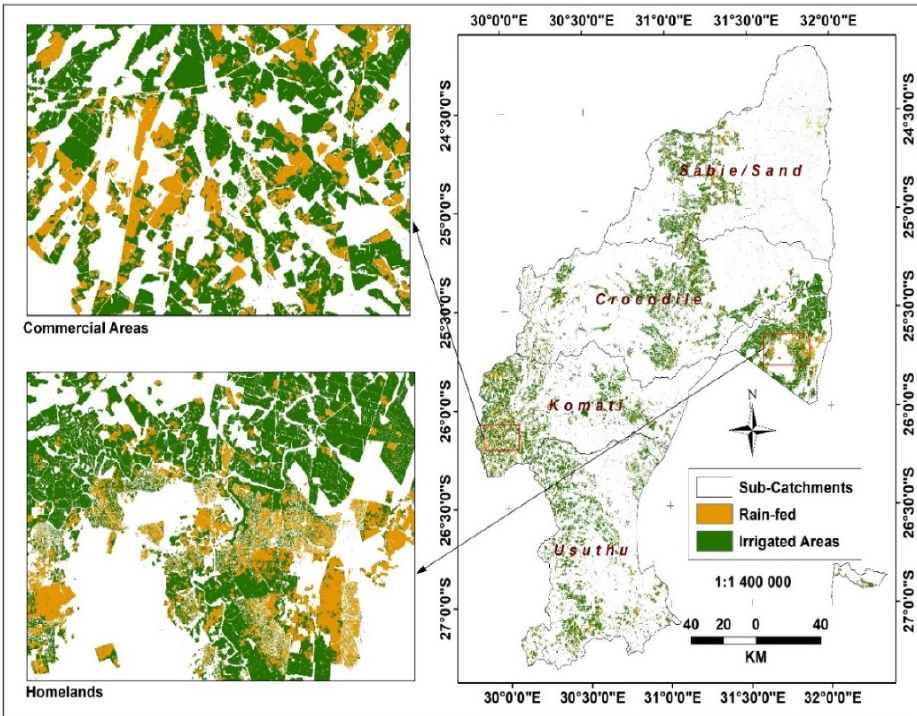
Figure 9. Irrigated and rainfed areas in the IUWMA in winter